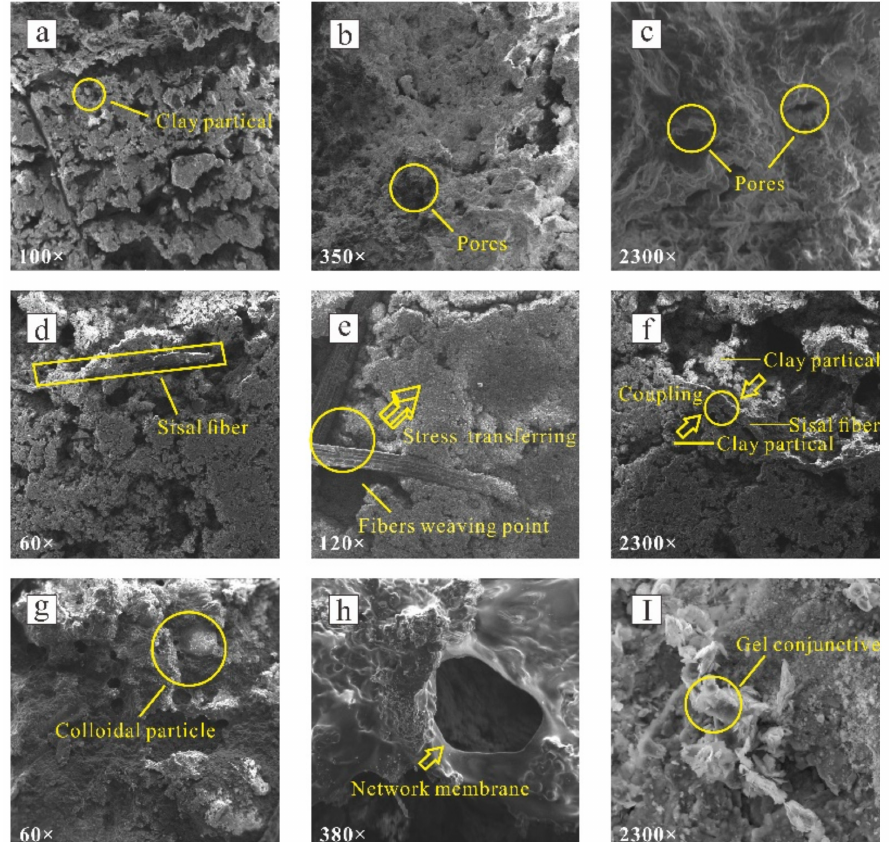
Figure 11. Microscopic mechanism diagram of the samples: ( a – c ) pure clay, magnification rates respectively 100 × , 350 × , and 2300 × ; ( d – f ) fiber-reinforced clay, magnification rates are 60 × , 120 × , and 2300 × , ( g , h , I ) PVAc reinforced clay, magnification rates 60 × , 380 × , and 2300 × ,